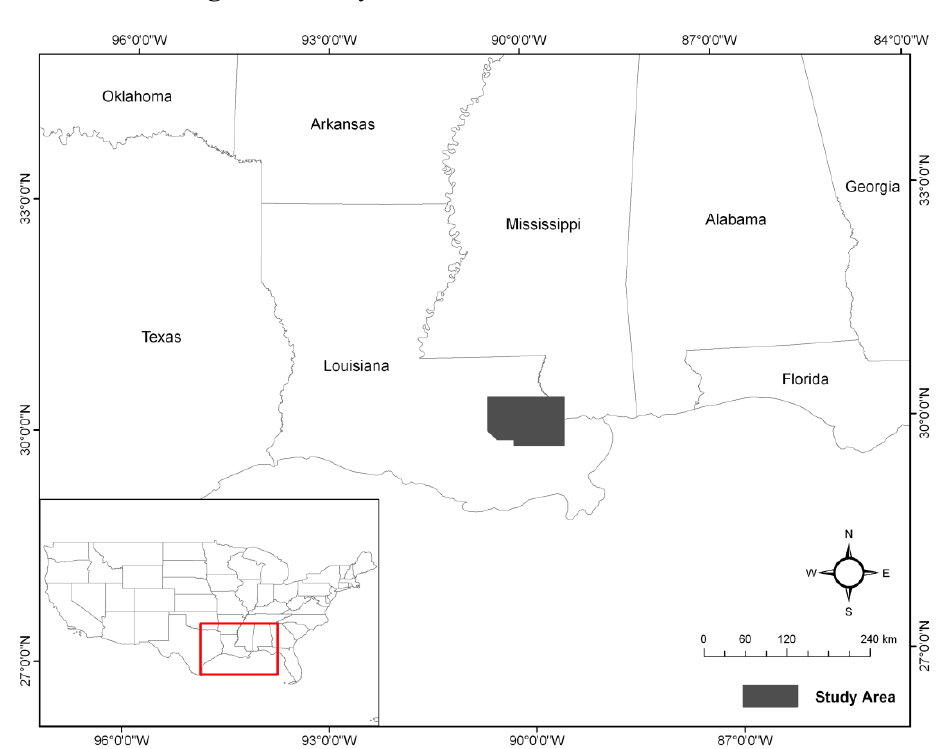
Figure 2. Study area in New Orleans, LA,